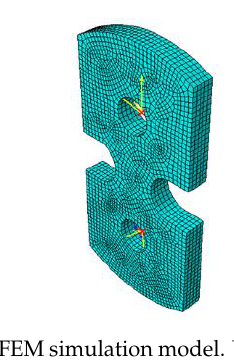
Figure 3. Boundary condition of CP-FEM simulation model. Upper half of the top pin hole was coupled with a reference point subject to displacement along vertical direction. Lower half of the bottom pin hole was fully constraint through the coupling with another reference